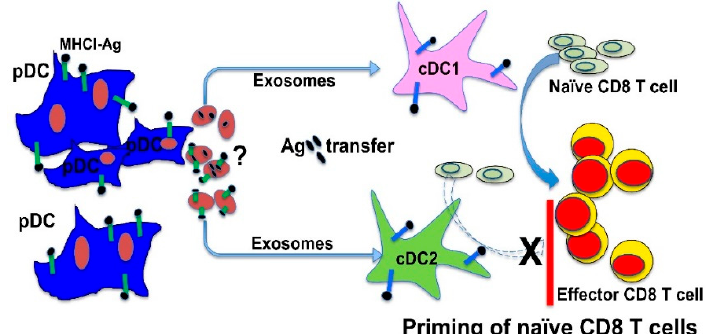
Figure 1. A novel mechanism for plasmacytoid DCs (pDCs) to cross-prime antigen-specific CD8 T cells by transferring antigens to bystander DCs through exosomes. Upon pDC-targeted vaccination, pDCs achieve cross-priming by transferring targeted antigens to conventional DCs (cDCs). Antigen transfer from pDCs to cDCs is mediated through pDC-derived exosomes (pDCexos), which similarly require bystander cDCs to prime antigen-specific CD8 T cells. While both cDC1s (type 1 cDCs) and cDC2s (type 2 cDCs) acquire antigens from pDCs similarly, cDC1s play a non-redundant role in pDC-mediated cross-priming, especially effector differentiation of antigen-specific CD8 T cells. How antigens are transferred from pDCexos to bystander cDCs remains unclear, and future studies will be required to determine whether pDCexos carry and transfer MHCI–Ag complexes to cDCs or carry intact antigens to be processed and presented by cDCs as reported for protein-loaded DCexos [95] .